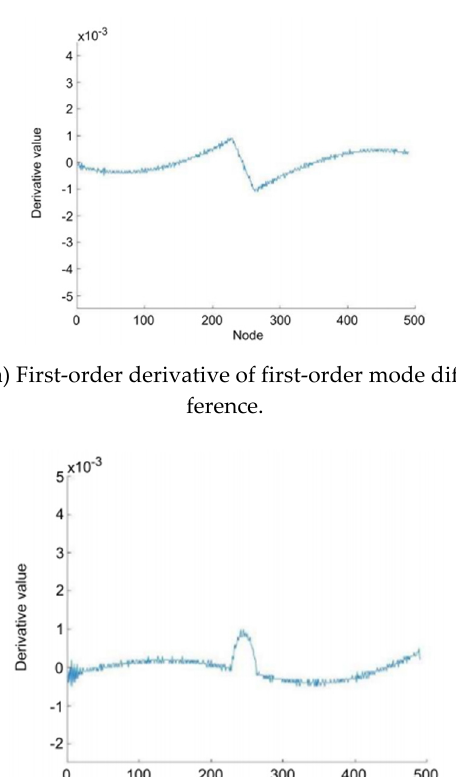
Figure 24. Displacement mode curves at different orders under Conditions 5 to 8.